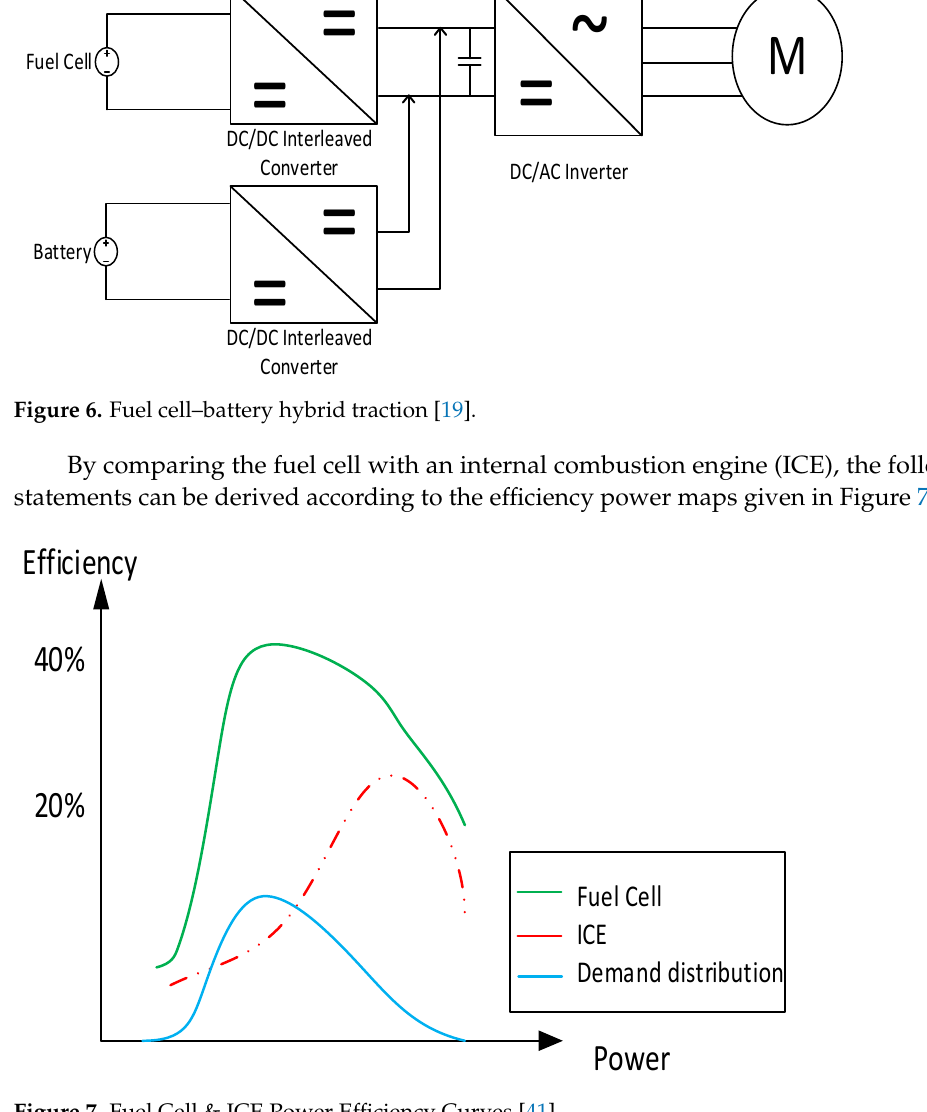
Figure 7. Fuel Cell & ICE Power Efficiency Curves [41].